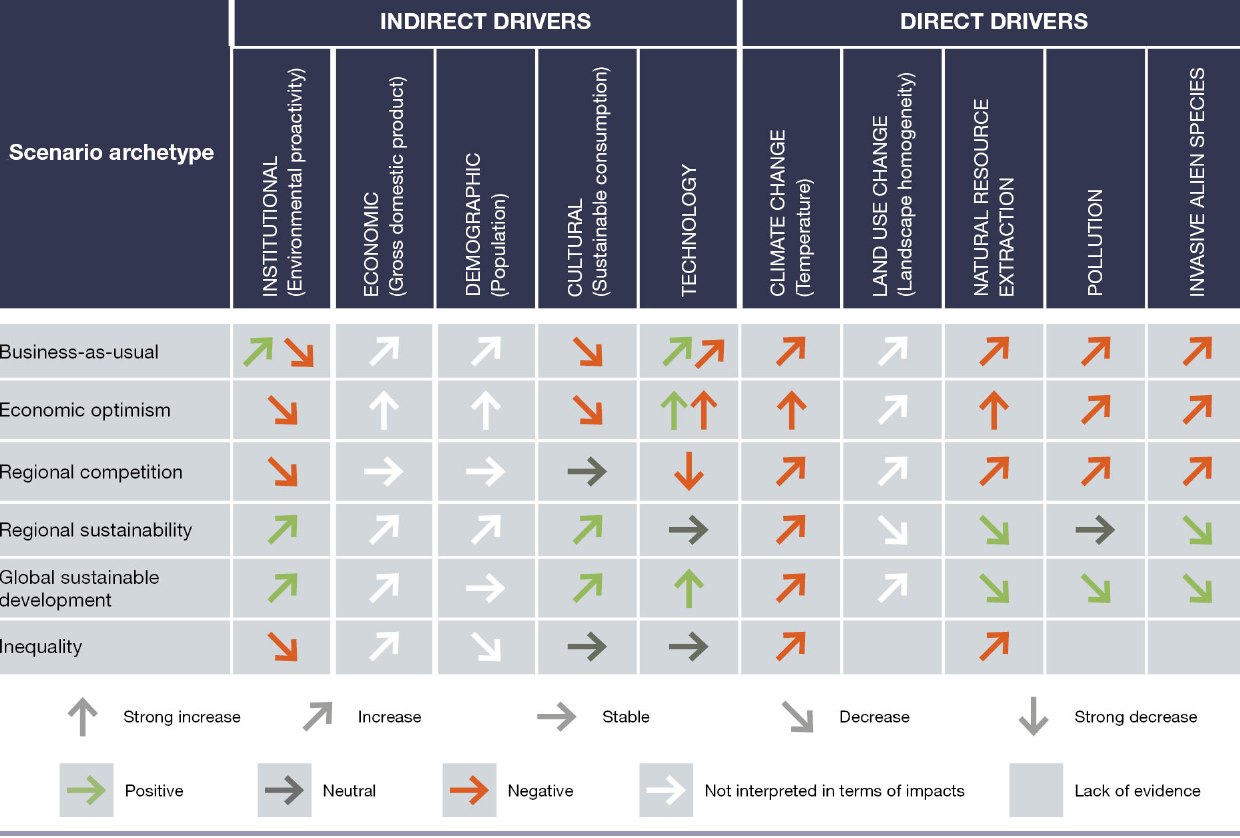
Figure 2. A description of the specific driver assumptions and their associated impacts is given in the following sections for each scenario